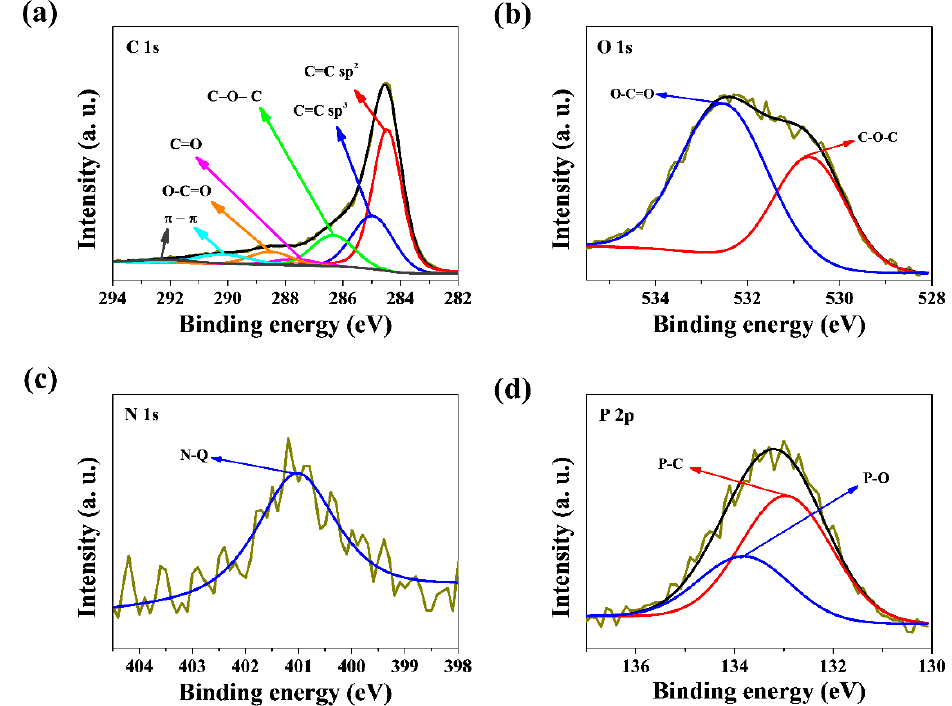
Figure 4. High-resolution XPS spectra: ( a ) C1s; ( b ) O1s, ( c ) N1s, and ( d ) P2p for the SCS-3:1 sample.